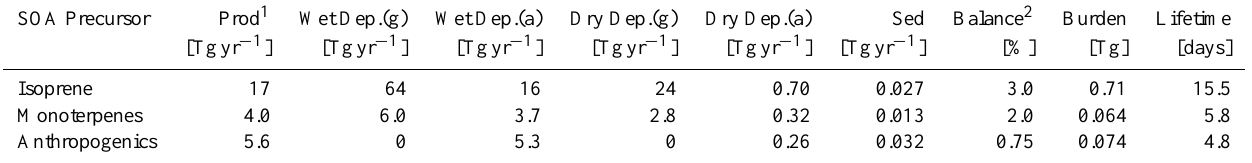
Table 2. Budget of modelled SOA per precursor species. (a): aerosol, (g) gas phase species. Dep.: deposition, Sed: sedimentation. SOA Precursor Prod 1 Wet Dep.(g) Wet Dep.(a) Dry Dep.(g) Dry Dep.(a) Sed Balance 2 Burden Lifetime [Tgyr − 1 ] [Tgyr − 1 ] [Tgyr − 1 ] [Tgyr − 1 ] [days] Isoprene 17 64 Monoterpenes Anthropogenics 5.6